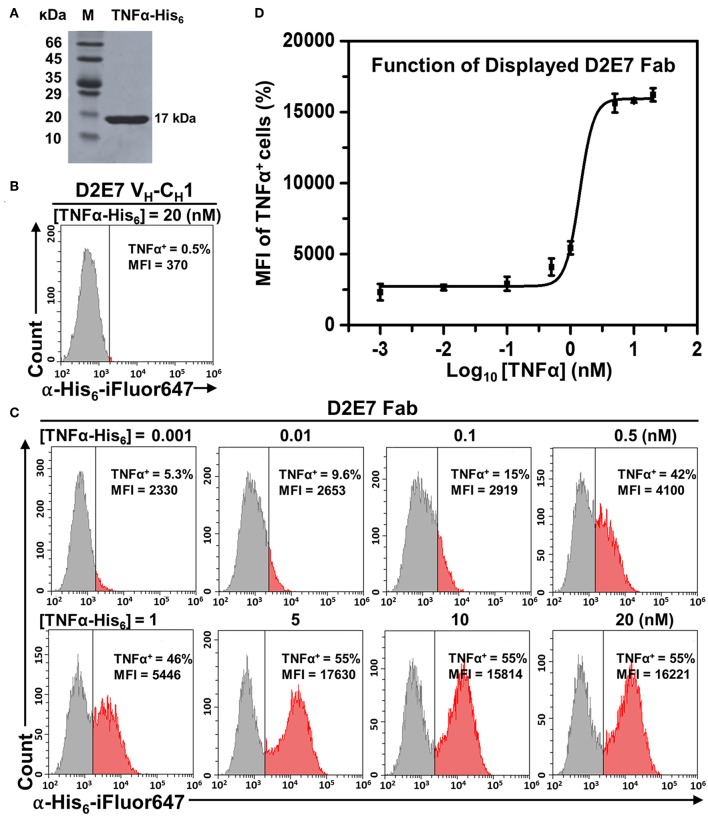
Function characterizations of displayed Fab D2E7. (A) Recombinant production of human TNFα as a His6 tagged protein. (B) Flow cytometry analysis of cells carrying the gene of Adalimumab (D2E7) heavy chain (VH-CH1) without its light chain. Expression was induced by 20 g/L galactose and cells were labeled with 20 nM TNFα-His6 and 0.1 μM anti-His6-iFluor647. (C) Flow cytometry analysis of cells carrying D2E7 Fab display construct. Induced cells were labeled with 1 pM −20 nM TNFα-His6 and 0.1 μM anti-His6-iFluor647 for TNFα+ cell quantification. (D) Sigmoidal curves depicting fluorescence intensities of TNFα+ cells as a function of TNFα concentrations. Data are presented as mean ± S.E. (n = 3 independent experiments). MFI, mean fluorescence intensity.